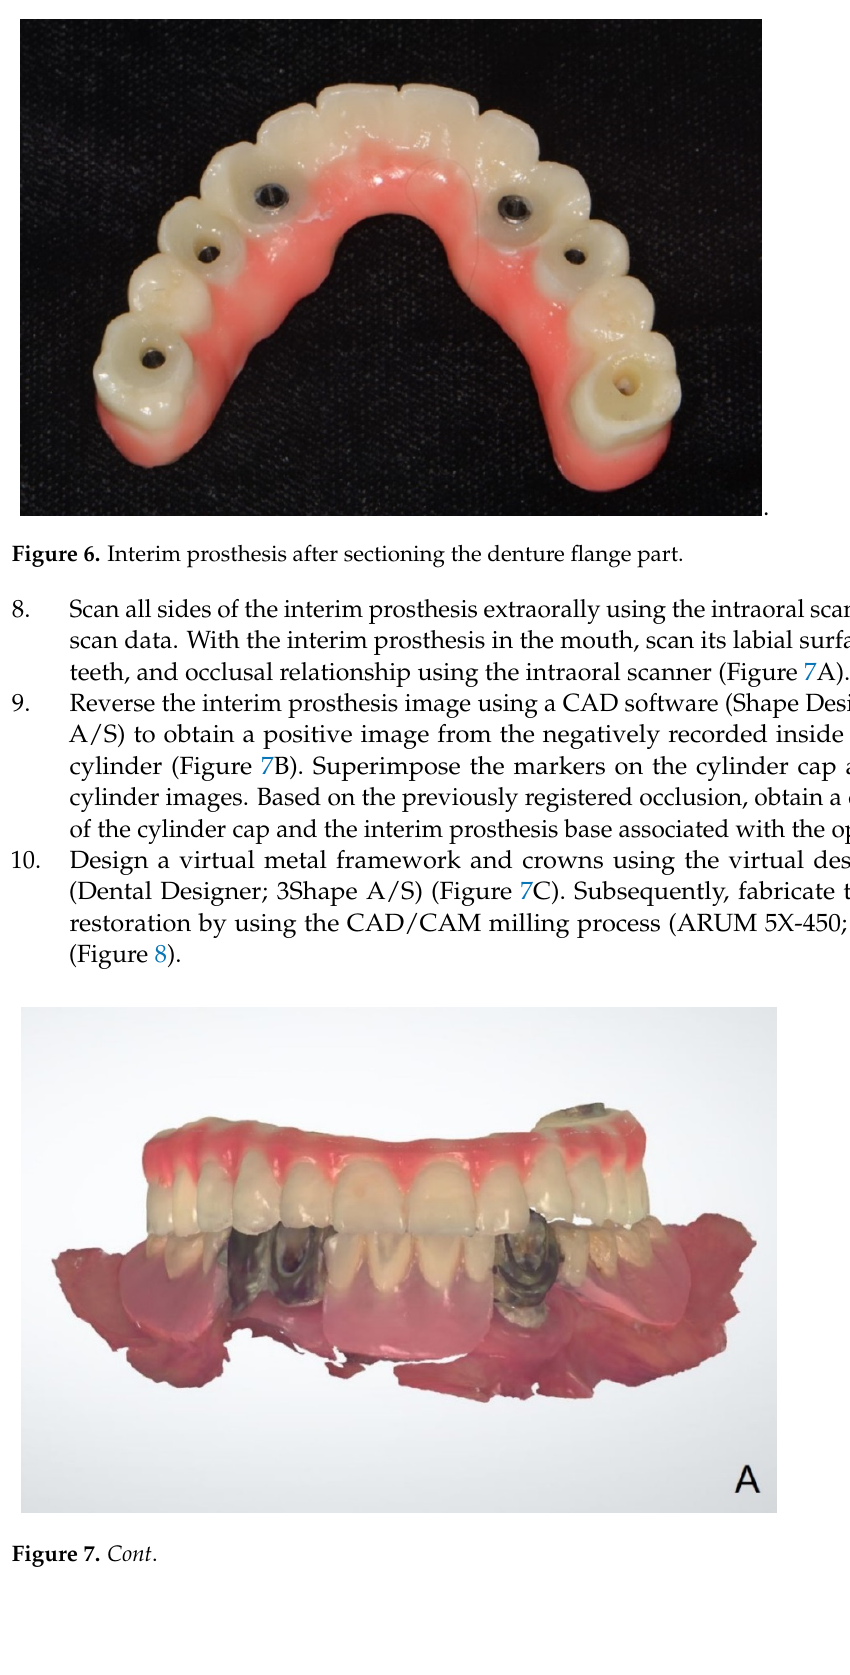
Figure 5. ( A ) Abutments in place. ( B ) Connection of the interim cylinders to the abutments. ( C ) Rubber dam placed beneath the interim cylinders to cover and protect the underlying soft tissue. ( D ) Evaluation of the interim restoration over interim cylinders.